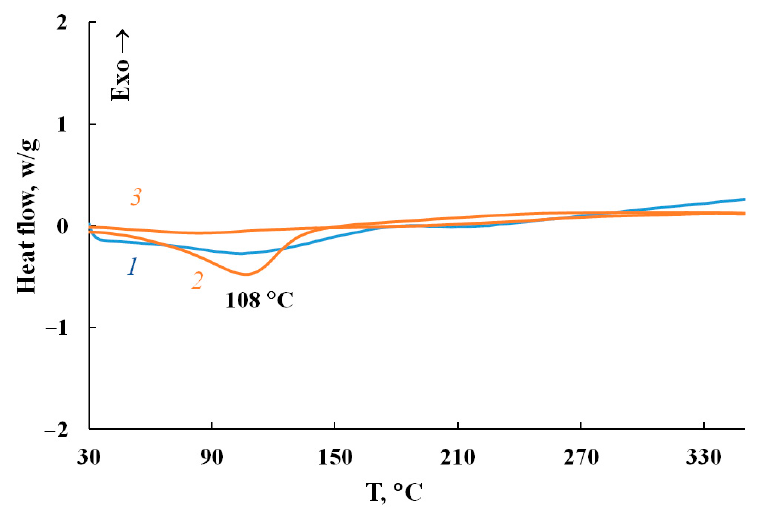
Figure 16. DSC thermograms of Fe 3 O 4 /P ‐ N ‐ PAA ( 1 ) and MNP/P ‐ N ‐ PAA ( 2 , 3 ) at heating in the nitrogen flow ( 1 , 2 —first heating, 3 —second heating).